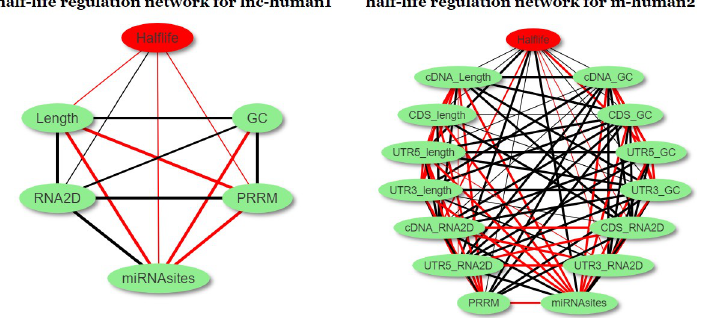
Fig 9. Half-life regulation networks for lnc-human1 and m-human2; red lines stand for positive correlation and black lines for negative correlation. The thick, medium, and thin lines represent the strong ( P < 1.0E − 33), medium (p 2 [1.0E − 33, 1.0E − 26]), and weak (p 2 (1.0E − 26, 1.0E − 5)) correlation, respectively. The meaning of the words Half- life, Length (_length), GC (_GC), and RNA2D (_RNA2D) in the lncRNA (mRNA) regulation network are lncRNA (mRNA) half-lives, length, GC contents, and RNA secondary structures. PRRM and miRNAsites are the total number of protein recognition motifs and miRNA-binding sites, respectively, in lncRNAs or mRNAs.